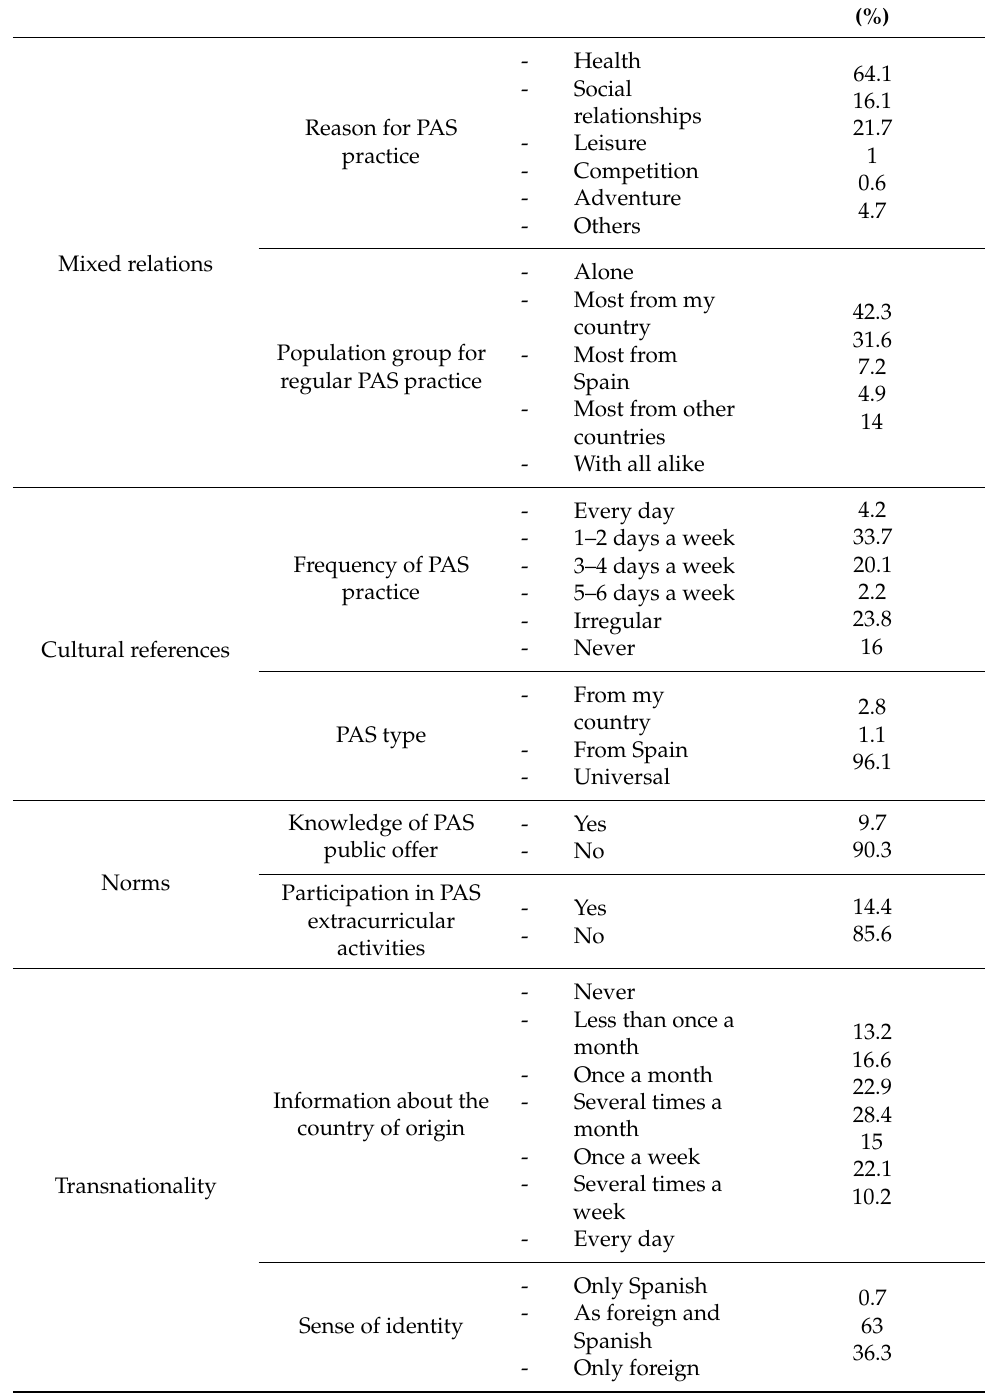
Table A3. Dimension frequencies of the